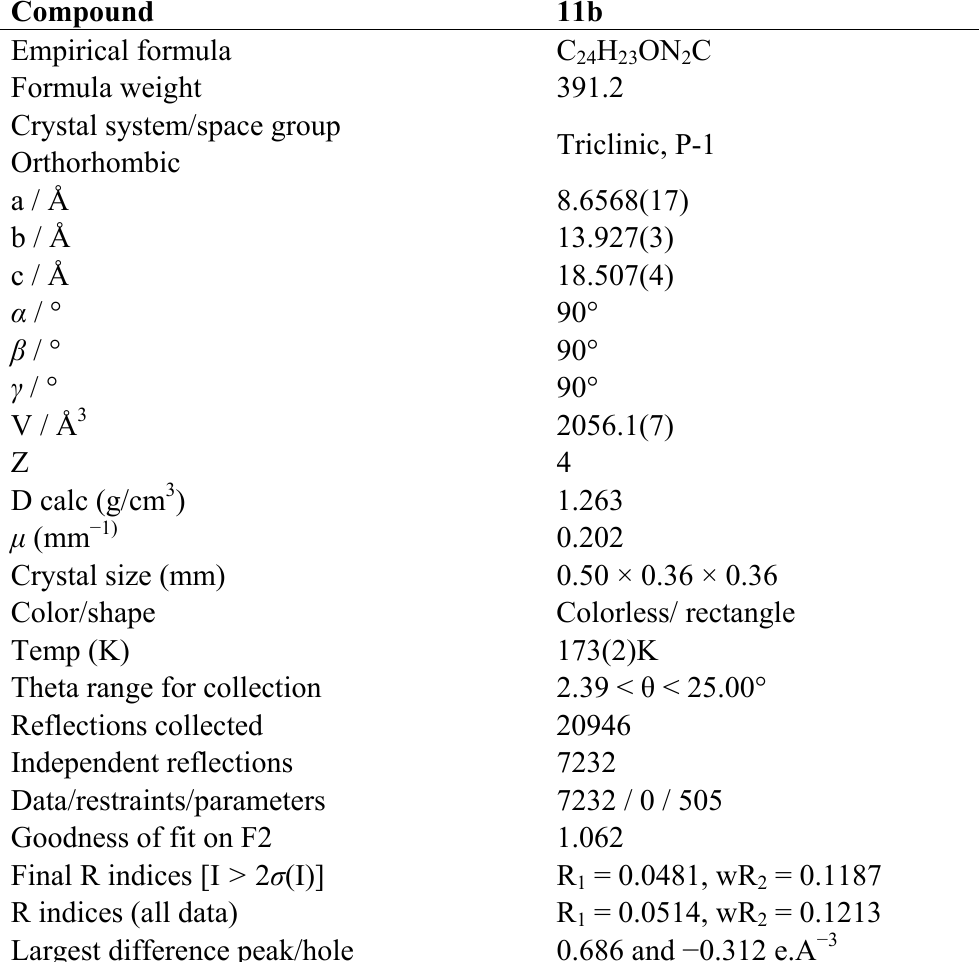
Table 1. Crystal structure and data refinement